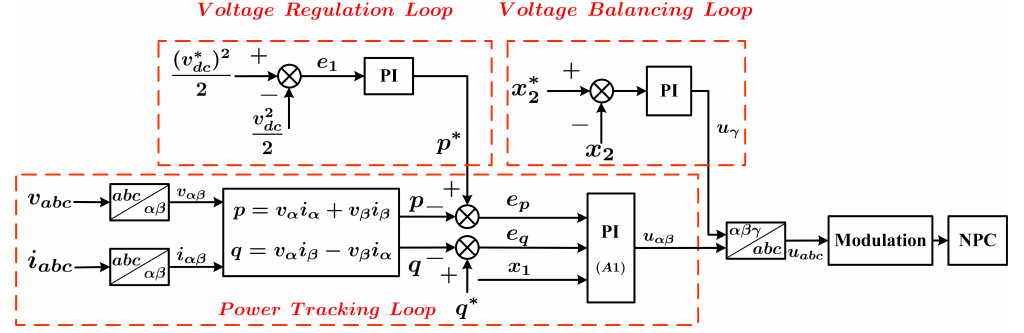
Figure 1. Control structure of PI-based